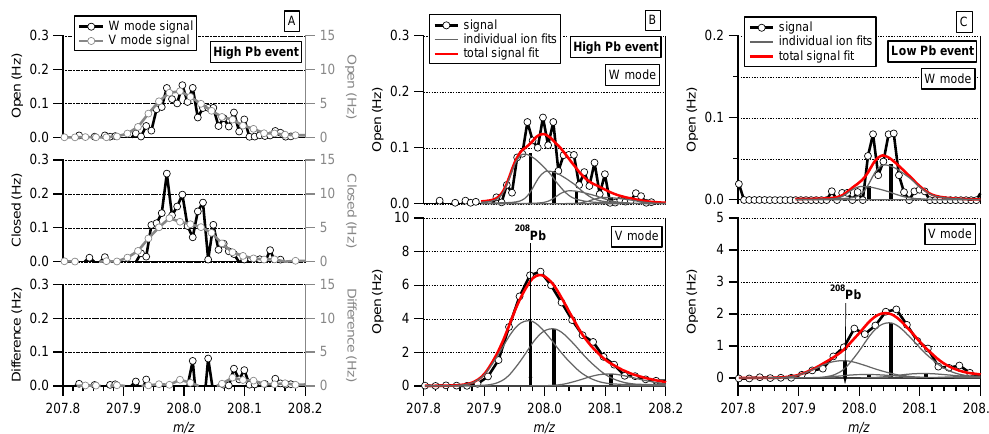
Fig. 2. 2.5min averaged open V and W mass spectra at m/z 208 obtained with the HR-AMS located at T0. Panel (A) compares open, closed and difference mass spectra for V and W modes. Panels (B) and (C) compare V and W mode open mass spectra at time periods with high and low Pb signal respectively (see Fig. 6). Black and grey lines and circles correspond to the AMS raw signal. Grey lines in panels B and C are modified Gaussian functions that represent the signal of individuals ions whose exact mass is indicated by the vertical black lines. The height of the vertical lines corresponds to the height of the modified Gaussian functions. Red lines are the sum of the individual ion peaks and represent the fitted total signal at the given nominal m/z